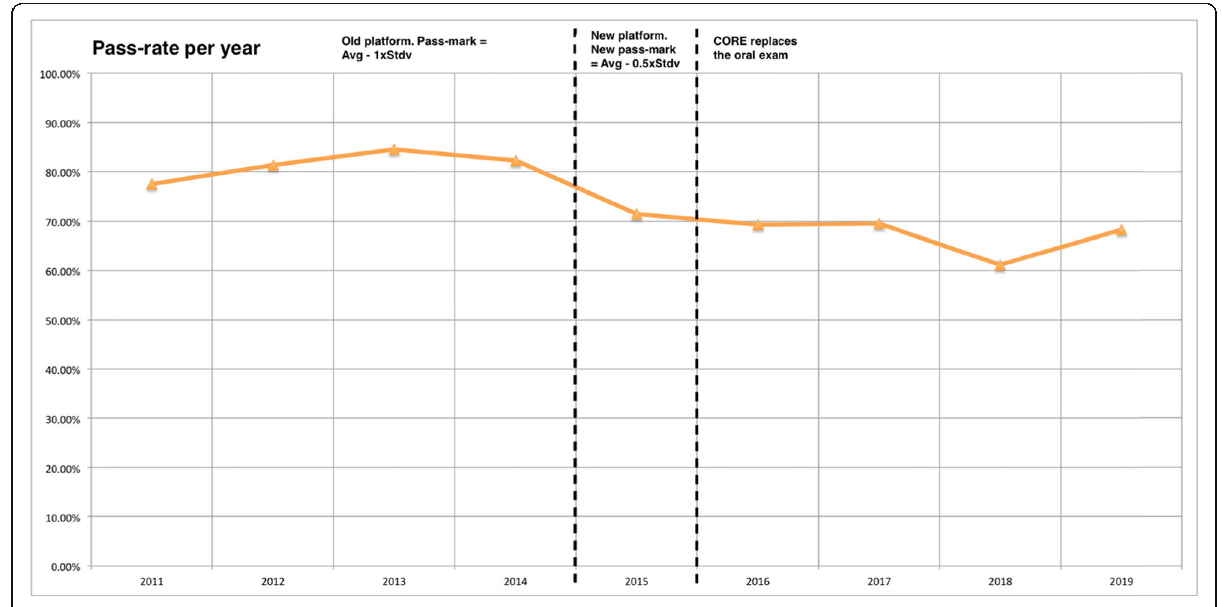
Fig. 4 Average pass-rate per